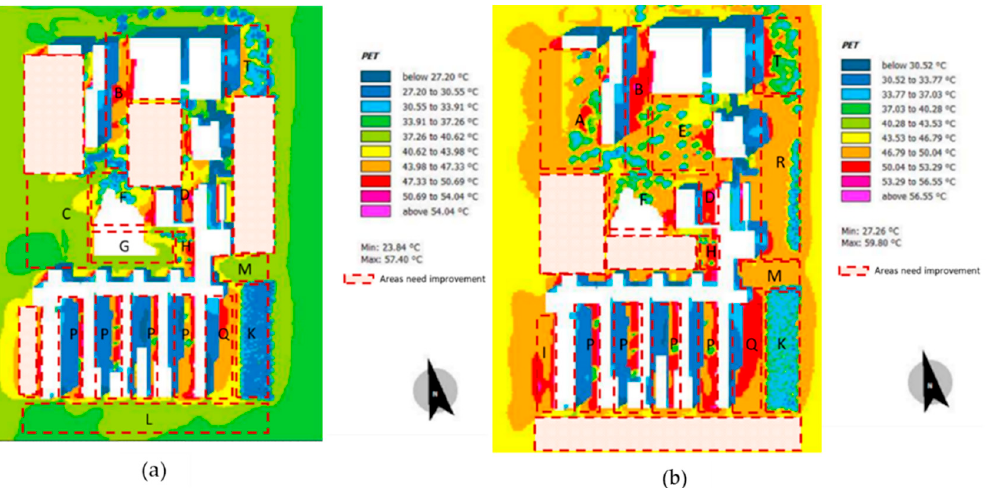
Figure 15. Visual results of PET and areas with PET values higher than need improvement sample p2m1c1, date 10 June, based on the microclimatic data of the campus ( a ), sample p3m1c1, date 11 June, based on the microclimatic data of the campus ( b ).